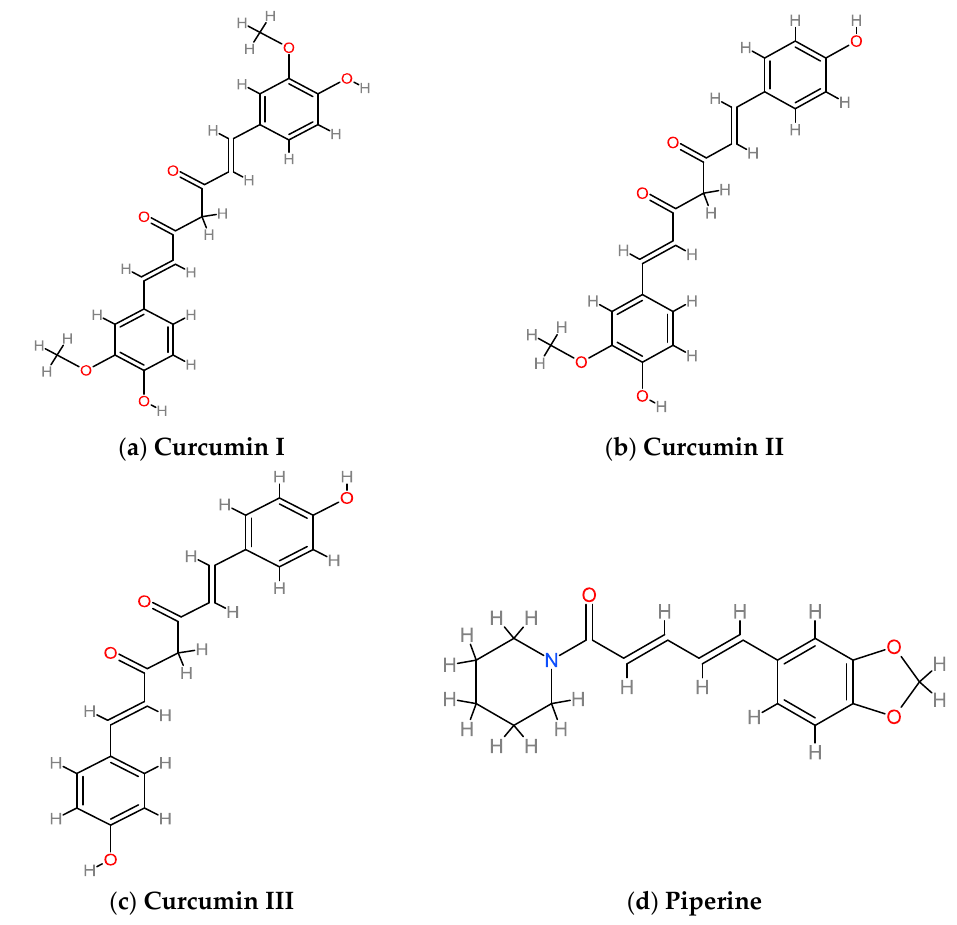
Figure 1. Chemical structure of curcumin and its two main analogs and piperine: ( a ) curcumin I (1E,6E)1,7-bis(4-hydroxy-3-methoxy-phenyl)-hepta-1,6-diene-3,5-dione; ( b ) curcumin II (1 E ,6 E )-1-(4-hydroxy-3-methoxyphenyl)-7-(4-hydroxyphenyl)hepta-1,6-diene-3,5-dione; ( c ) curcumin III (Bis(4-hydroxyphenyl)-1,6-heptadiene-3,5-dione; and ( d ) piperine, (2E,4E)-5-(benzol( d )[1,3]dioxol-5-yl)-(piperidin-1-y)penta-2,4-dien-1-one.